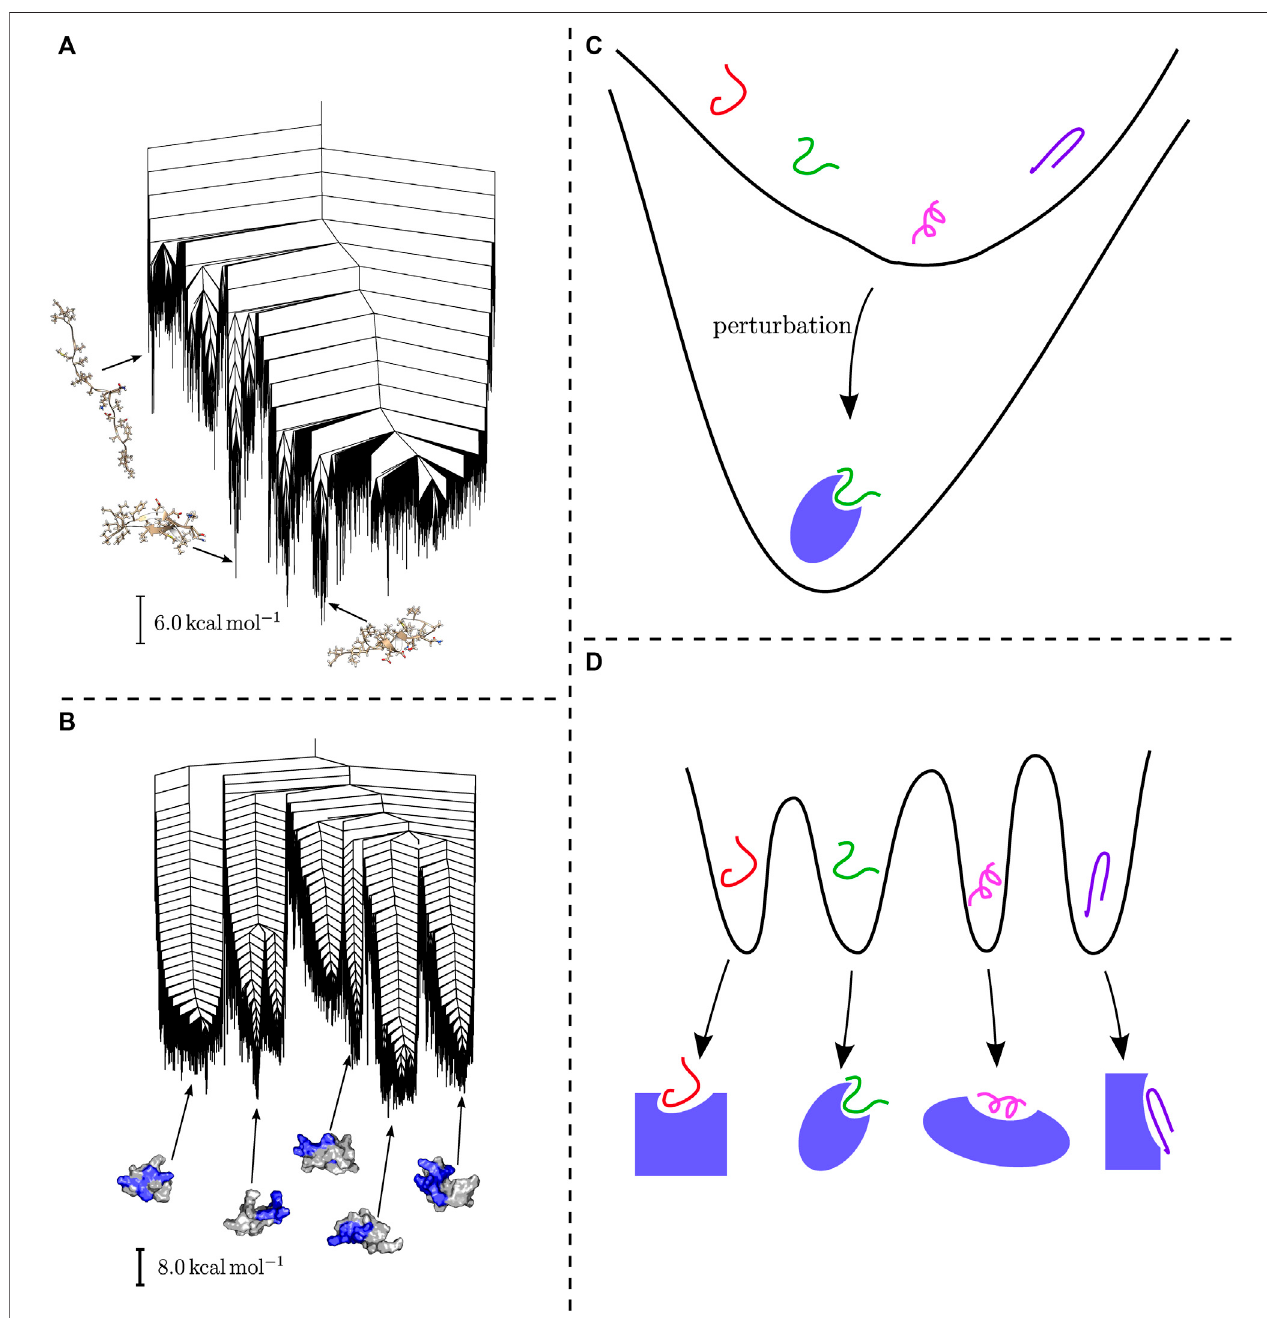
FIGURE2|(A) Thedisconnectivitygraphfortheenergylandscapeofanamyloid- β monomeradaptedfrom(RöderandWales,2018b)exhibitsashallowlandscape with small subfunnels, while (B) the landscape for the H4 histone tail, adapted from (Röder, 2021), supports multiple funnels with distinct structural ensembles. (C) Schematicrepresentationofhowbindingmayaffectshallowenergylandscapes. (D) Conformationalselectionbasedonamultifunnelenergylandscapeallowsbindingto alternative partners for a single peptide or protein.